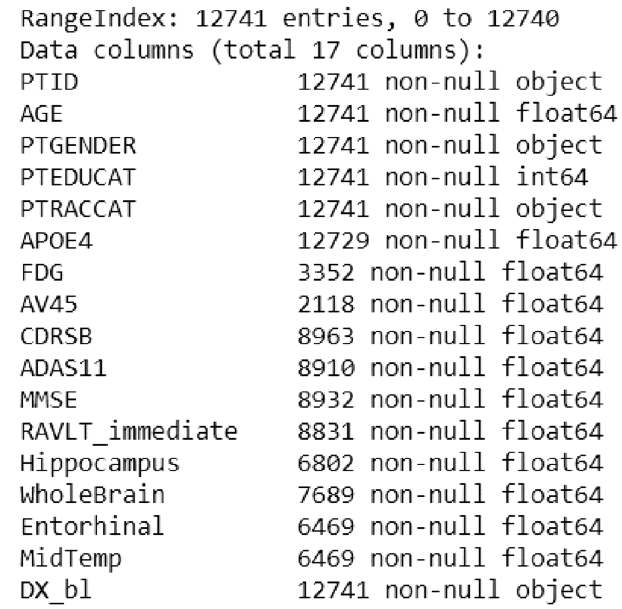
Figure 2. Data set summary.